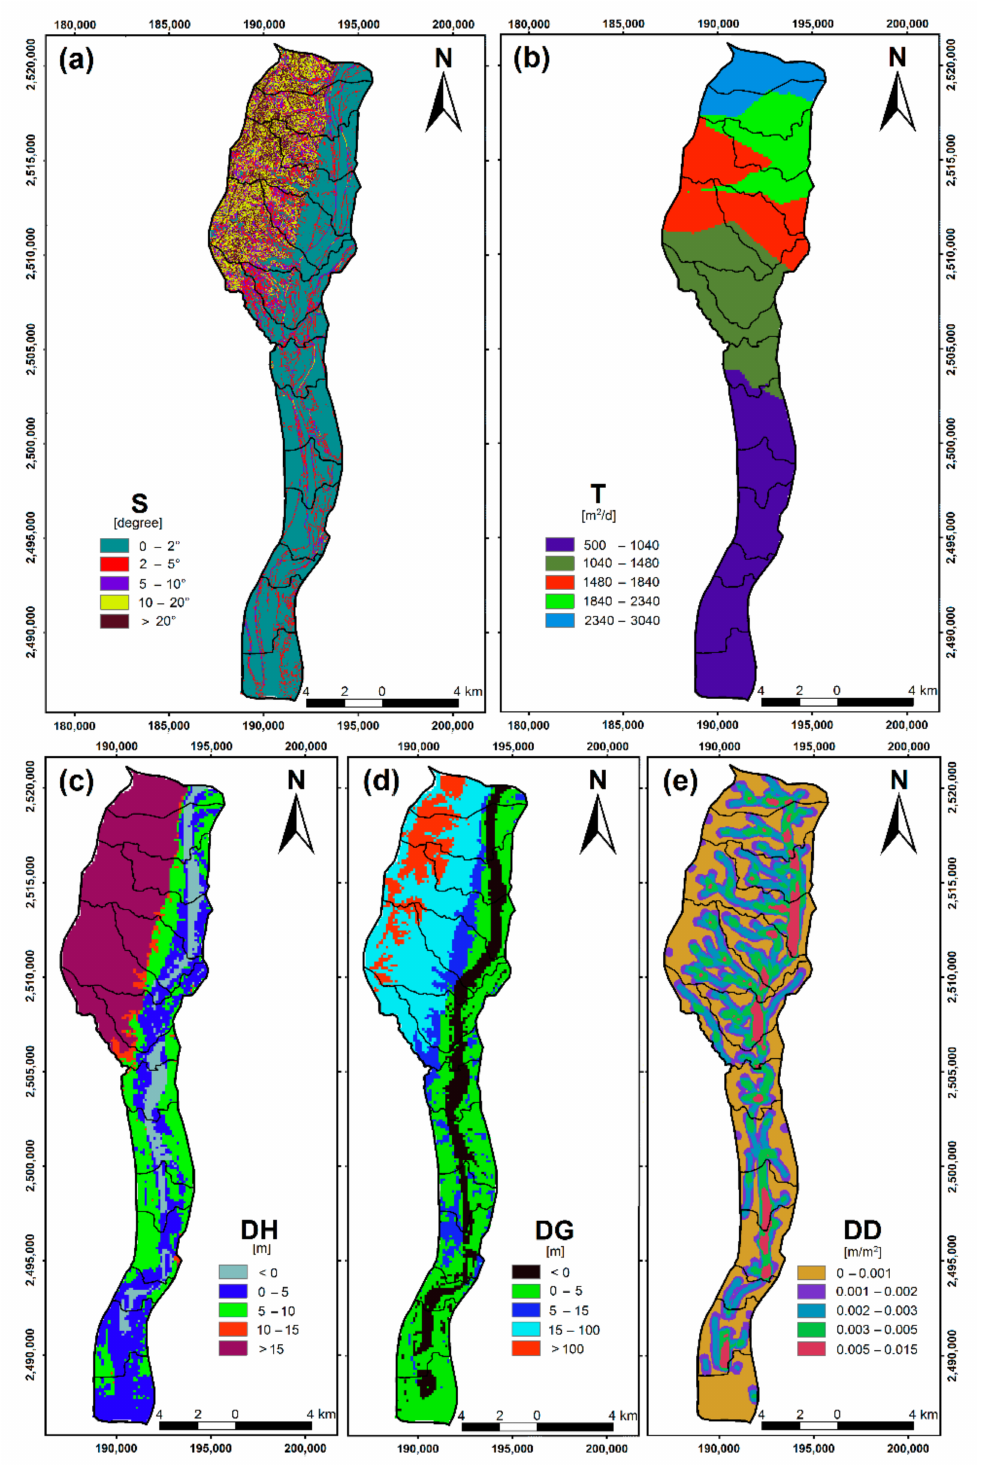
Figure 3. The selected thematic layers using GIS: ( a ) Slope, ( b ) Transmissivity, ( c ) River-groundwater levels difference, ( d ) Depth of groundwater, and ( e ) Drainage